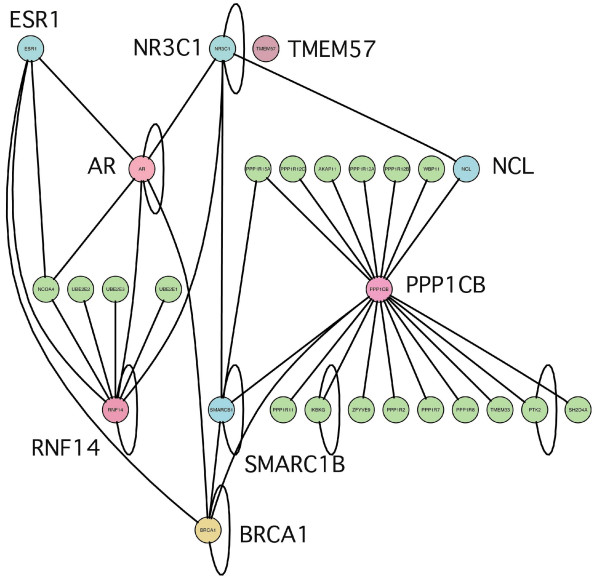
Protein-protein interaction network. Protein-protein interaction network involving PPP1CB, RNF14, TMEM57, and BRCA1. TMEM57 has no interactors, while RNF14, TMEM57 are connected through BRCA1 and AR, ESR1 and BRCA1, through SMARC1B and NCL, or through NR3C1 and SMARCB1. Genes from the top-scoring triplets are shown in pink, BRCA1 in yellow, the other connecting proteins in light blue.